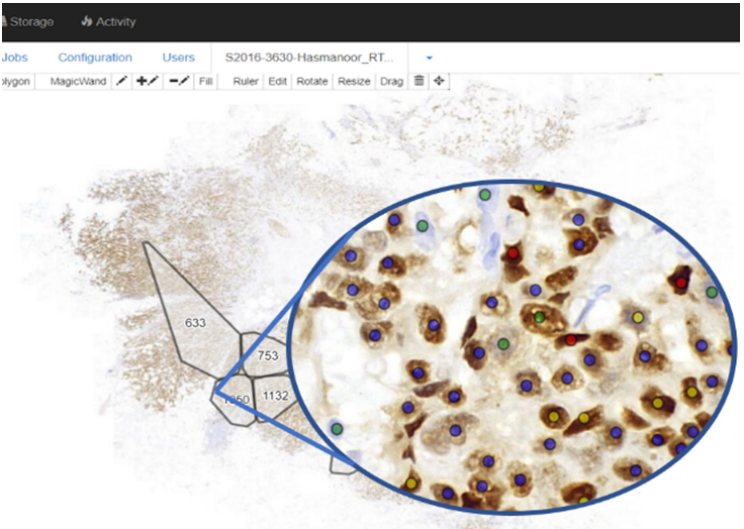
Figure 5. Part of the Cytomine interface, which enabled online annotation on whole-slide images and convenient working on gigabyte data of images. The different color dots show the different classes: green for negative, blue for positive-weak, yellow for positive-moderate and red for positive-strong class